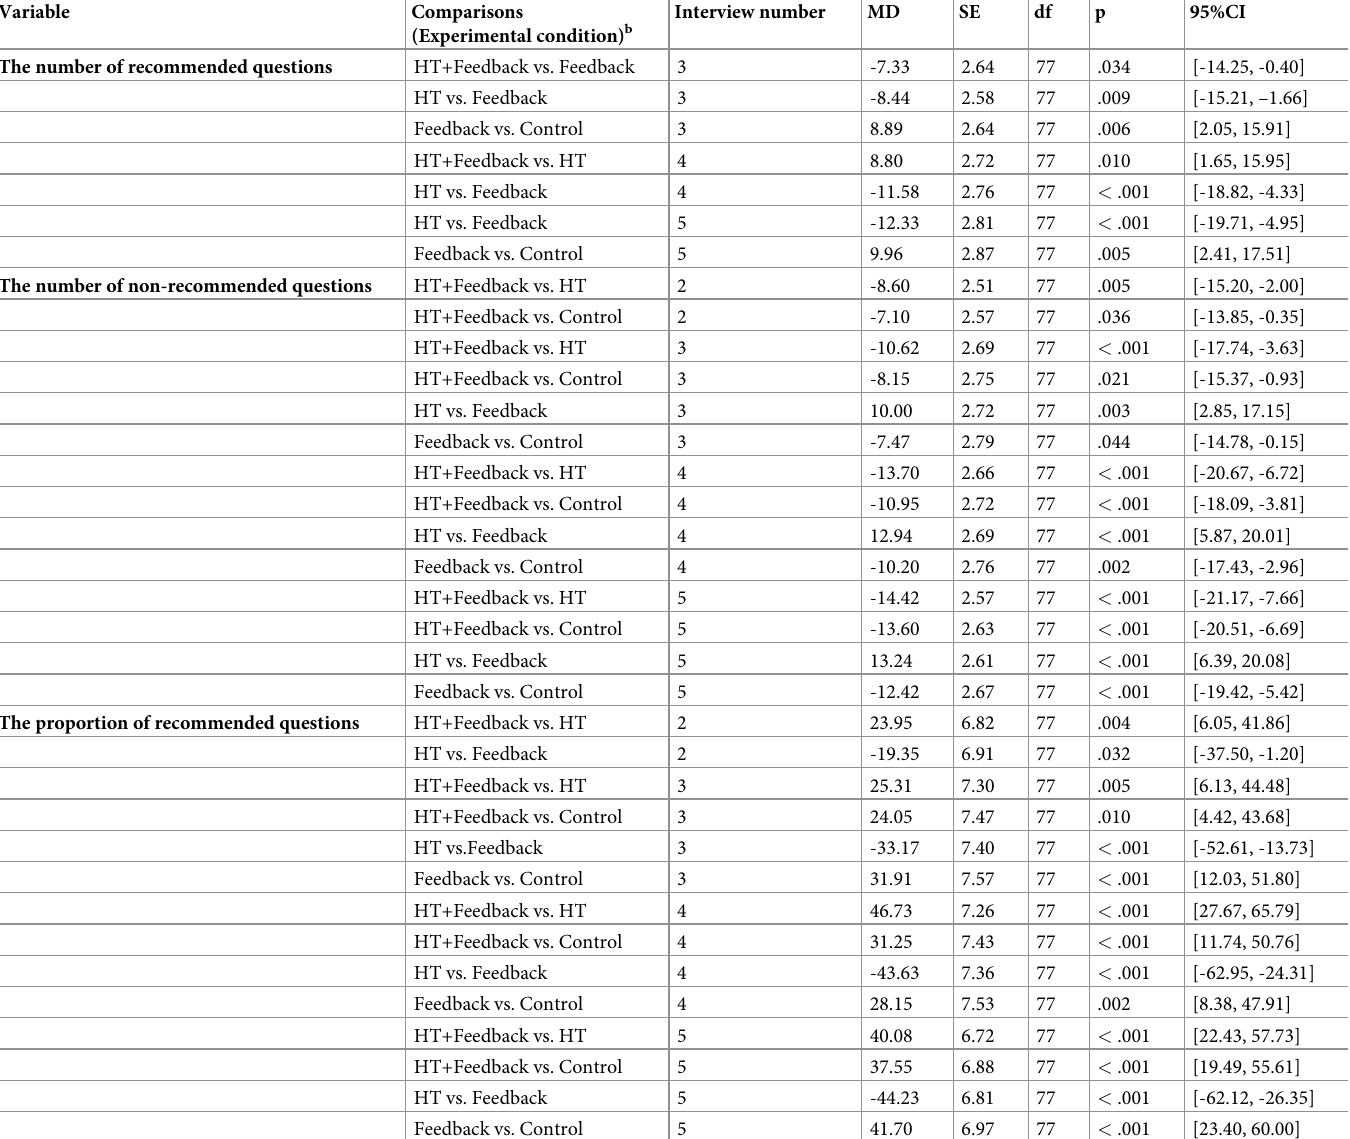
Table 4. a Planned comparisons on the types of questions between experimental conditions over